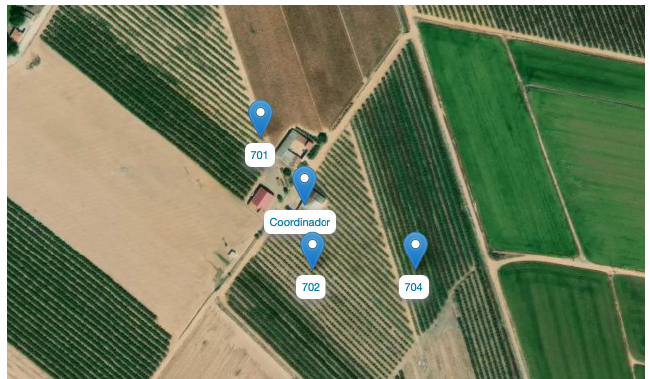
Figure 10. Diagram of the network deployed in Farm